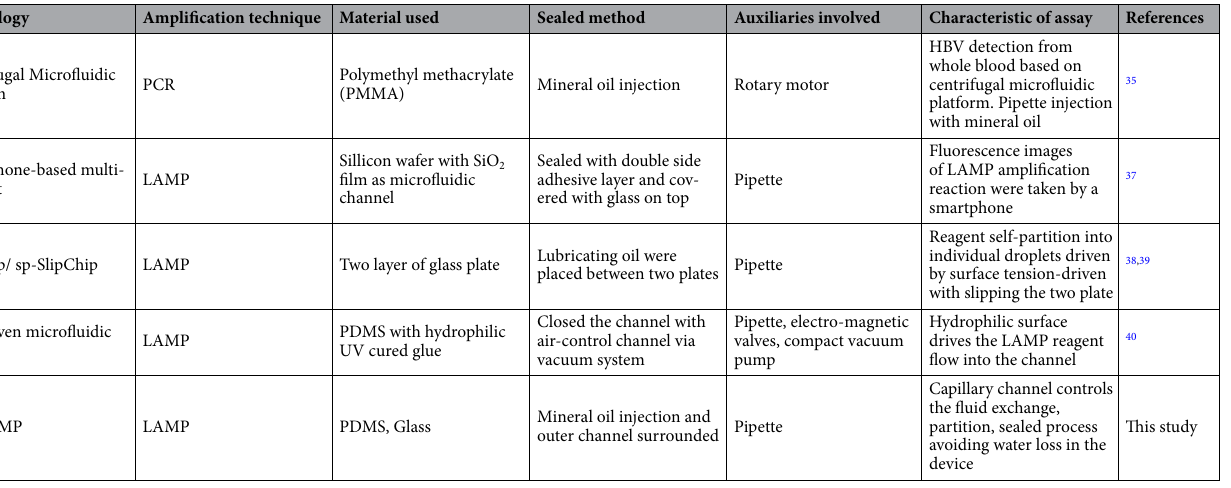
Table 1. Comparison of recent passive-driven approach of nucleic acid amplification microfluidic